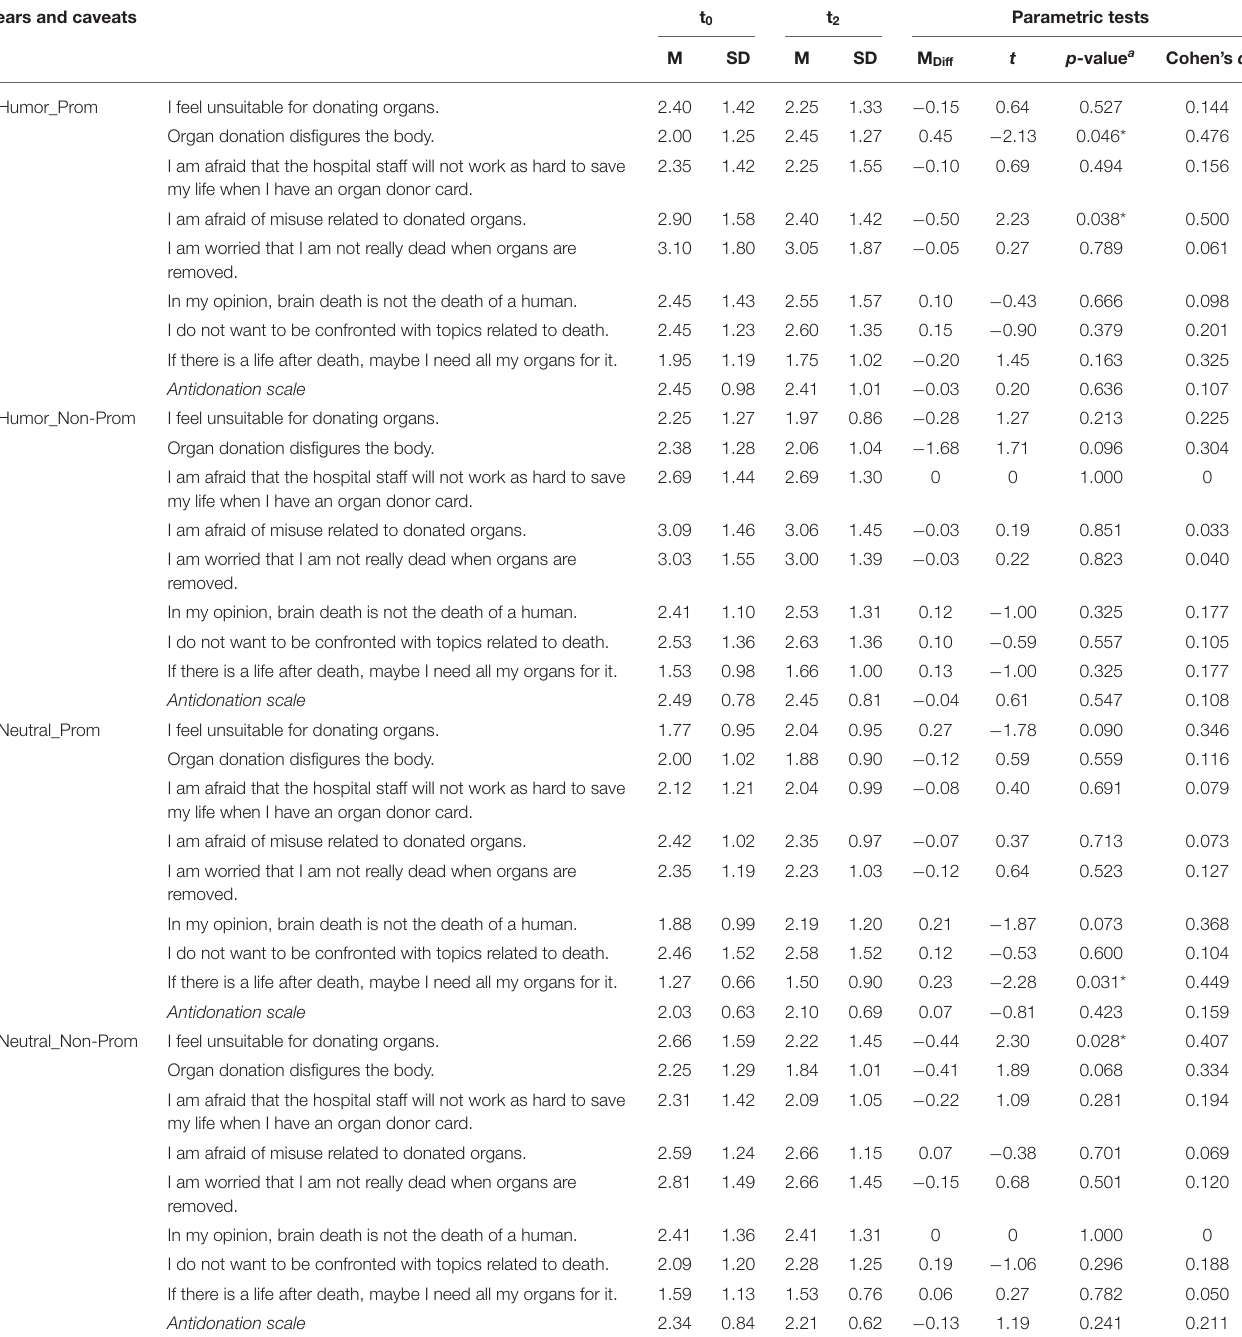
TABLE 3 | Antidonation items at t 0 and t 2 ( n = 110). Fears and